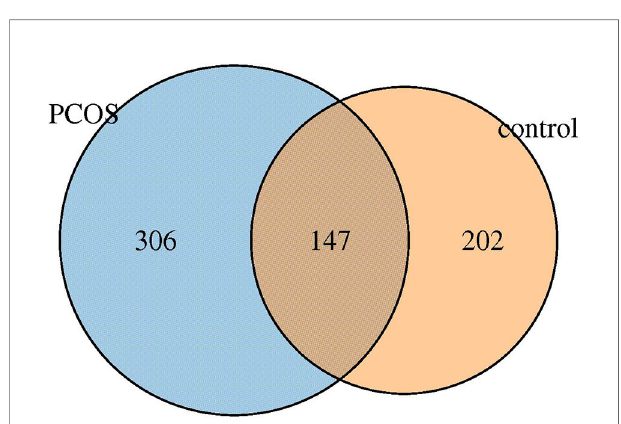
FIGURE 1 | Venn diagram of total polycystic ovary syndrome (PCOS) group and total control